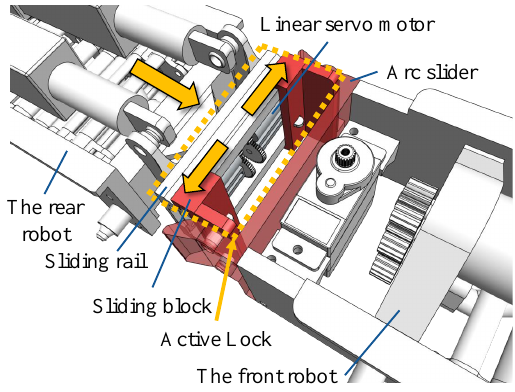
Figure 3. The series connector of the SWC